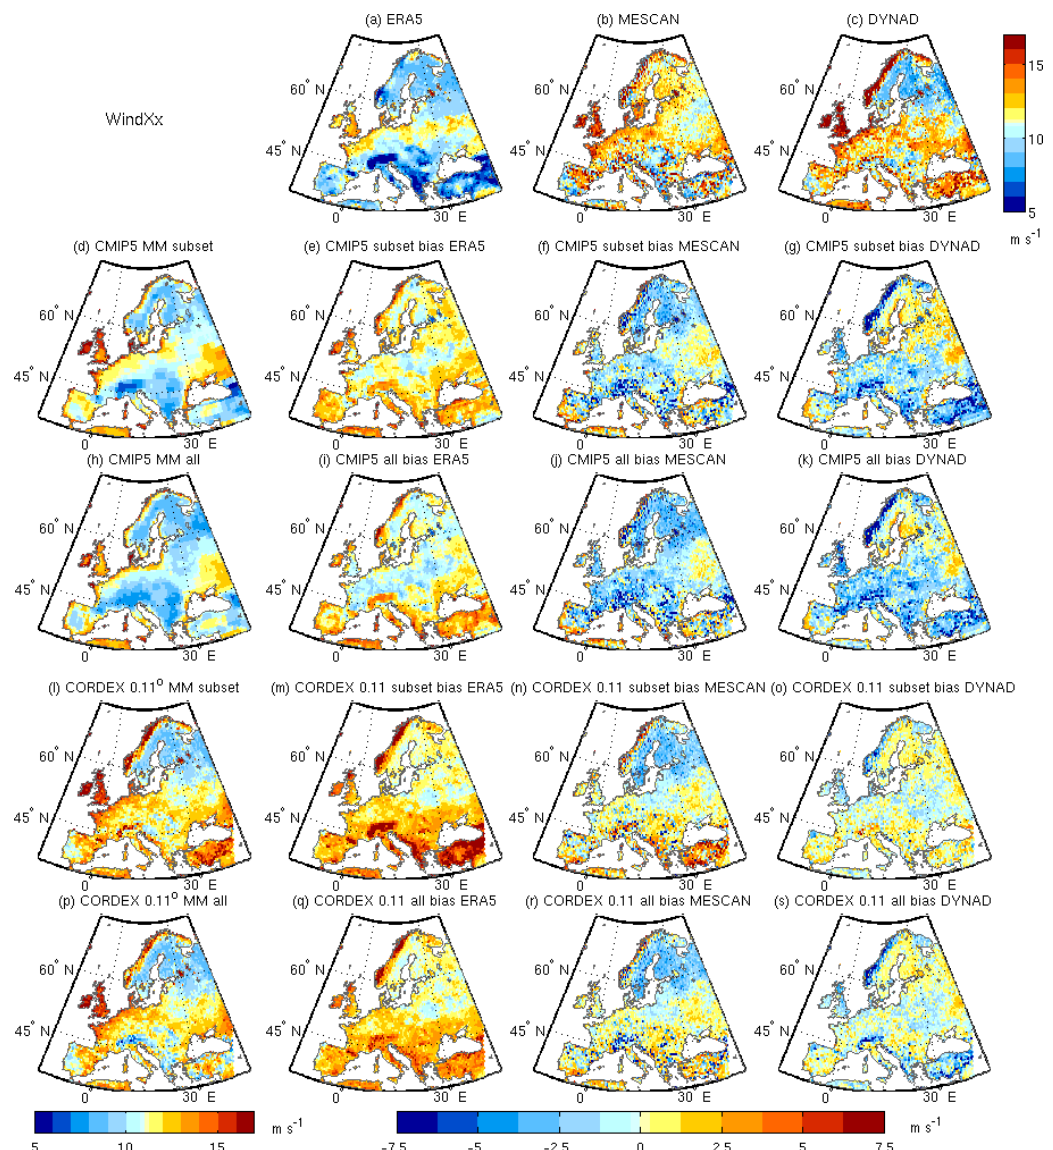
Figure 4. Climatological mean of annual maximum wind for the period 1979–2005 for (a) ERA5, (b) MESCAN, (c) DYNAD, and the multi-model median of the common subset of models for (d) CMIP5 and (l) CORDEX 0.11 ◦ as well as their biases with respect to the reanalyses datasets (e–g, m–o) . Panels (h–k) and (p–s) are the same but for the full ensembles of CMIP5 and CORDEX. Units: metres per